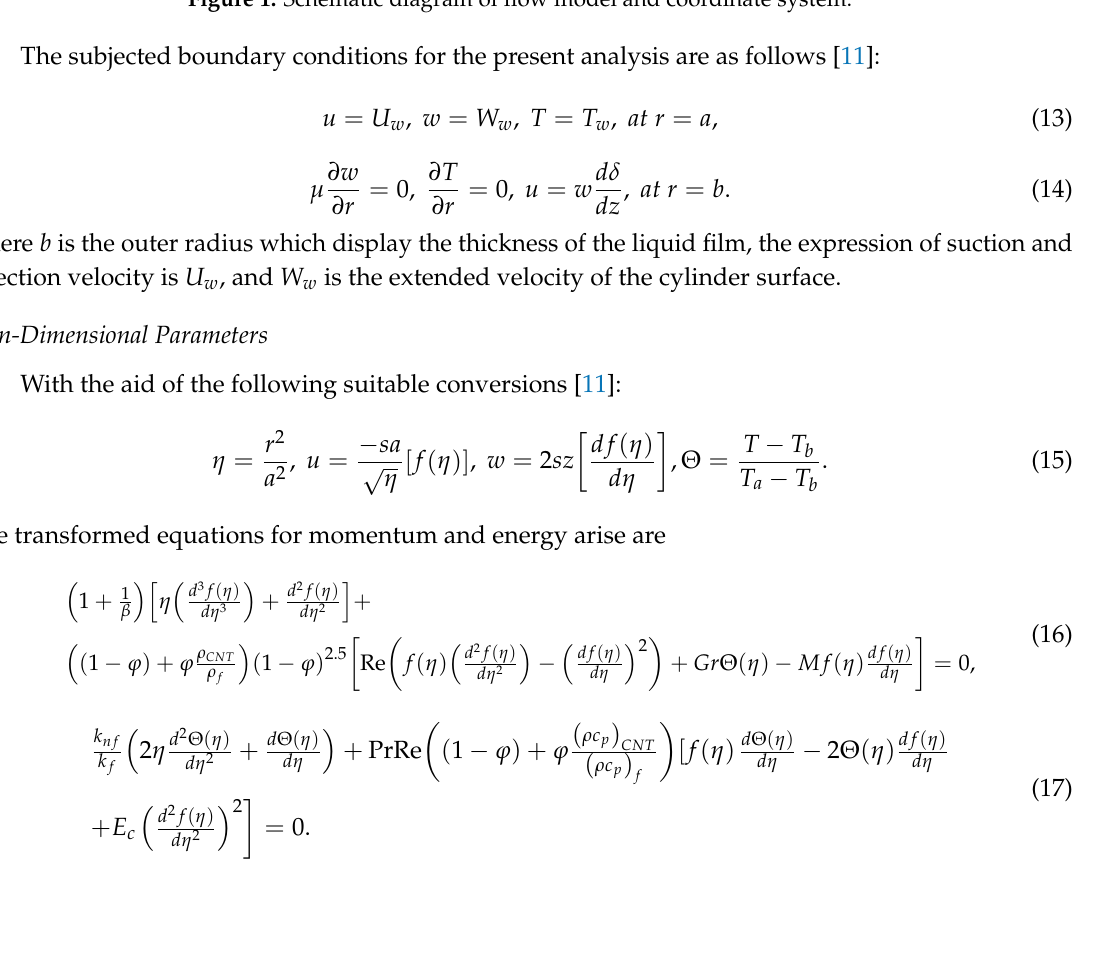
Figure 1. Schematic diagram of flow model and coordinate system.